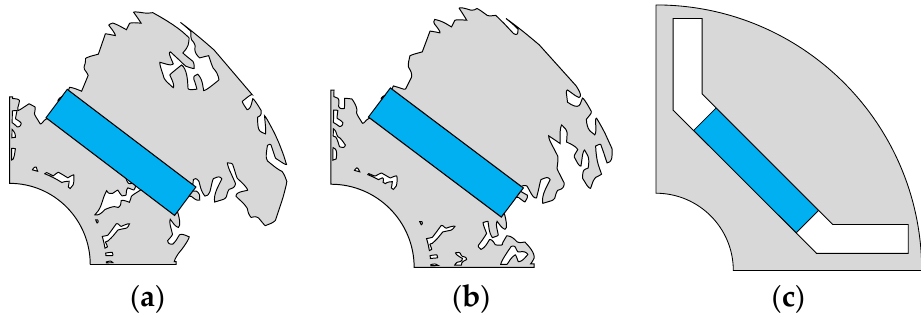
Figure 12. Selected optimized rotor topologies and the reference model. ( a ) is Model 0, the 𝑇 𝑎𝑣𝑔 is 2.41 Nm, and the 𝑇 𝑟𝑖𝑝𝑝𝑙𝑒 is 0.38 Nm. ( b ) is Model 1, the 𝑇 𝑎𝑣𝑔 is 2.57 Nm, and the torque ripple 𝑇 𝑟𝑖𝑝𝑝𝑙𝑒 is 0.85 Nm. ( c ) is the reference model, the T avg is 1.83 Nm, and T ripple is 0.53 Nm.